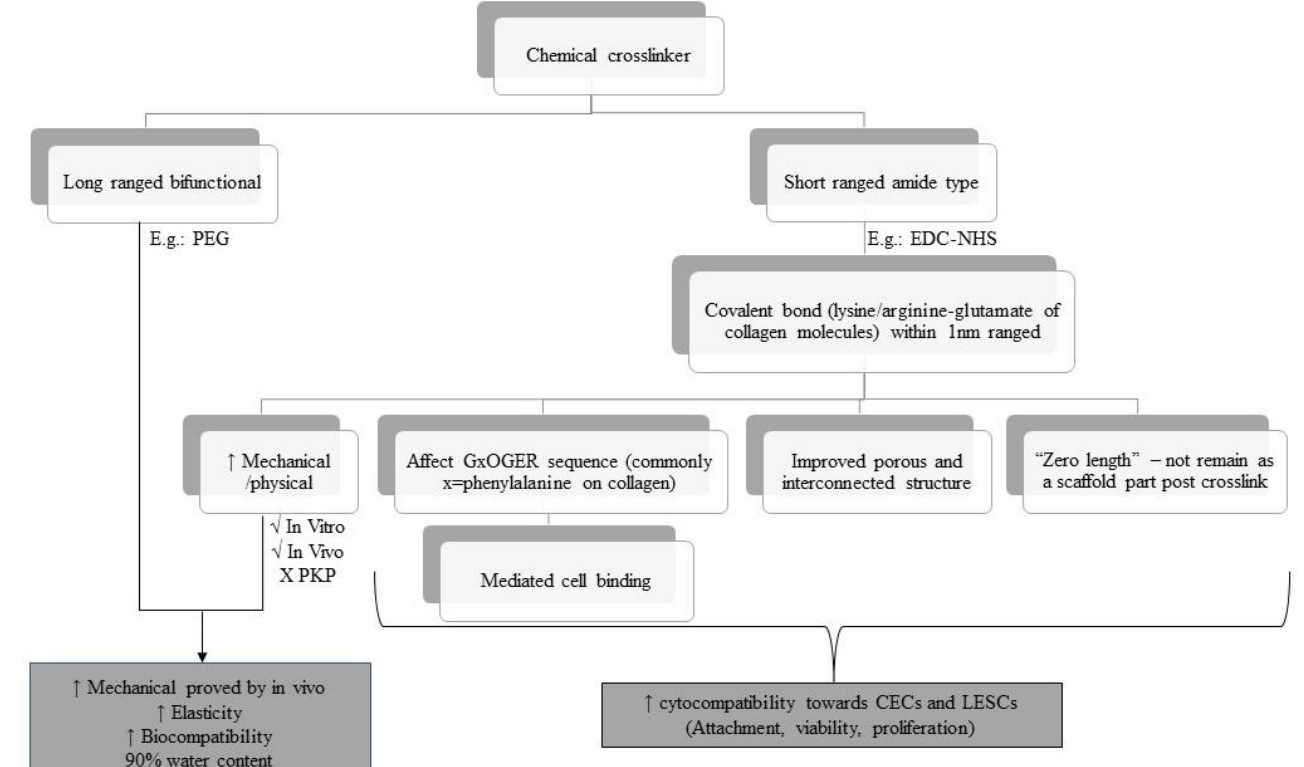
Figure 5. Overview of the chemical cross-linkers used over the last 10 years based on selected arti-